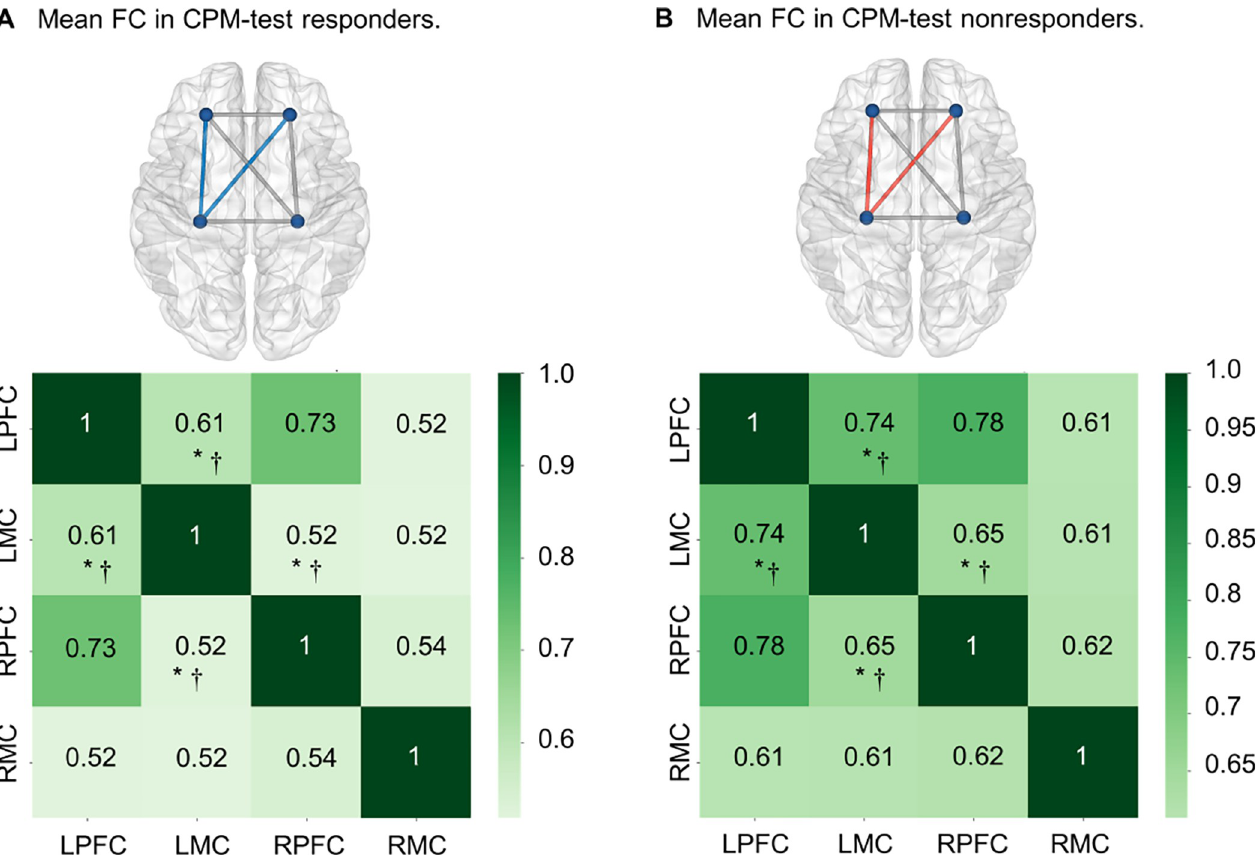
Fig 3. Heatmap visualization of FC across regions of interest in Z-values. Nonresponders presented higher connectivity than responders between LMC and bilateral PFC. Blue color edges represent significantly lower values and red color edges represent significantly higher values, relative to the comparison between groups. A. Mean FC by region of interest in CPM-test responders. B. Mean FC by region of interest in CPM-test nonresponders. FC: functional connectivity; CPM-test: conditioned pain modulation test. LPFC: Left prefrontal cortex; LMC: Left motor cortex; RPFC: Right prefrontal cortex; RMC: Right motor cortex. � p < 0.05. † FC between regions of interest that were associated with CPM-test groups despite the interaction effect of multiple psychiatric diagnoses.